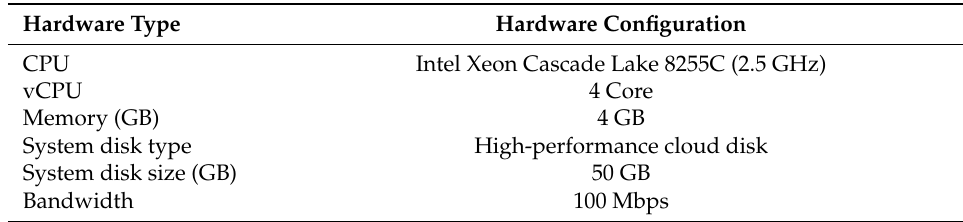
Table 6. Virtual machine hardware configuration.